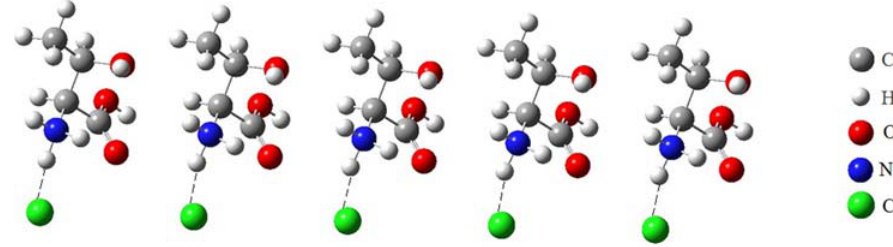
Figure 1. Hydrogen-bonding network of threonine hydrochloride cluster optimized at M06-2X / 6-31++G(d,p)